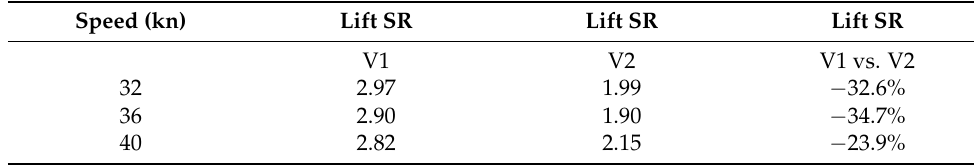
Table 14. Comparison of lift computed on